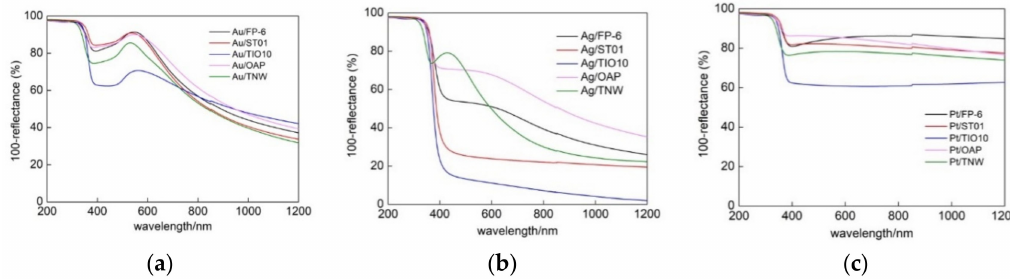
Figure 4. Di ff use reflectance spectroscopy (DRS) spectra of noble metal (NM)-modified samples (TNW, OAP and commercial titania: FP-6, ST01 and TiO10) for: ( a ) Au, ( b ) Ag and ( c ) Pt; taken with BaSO 4 as a reference.